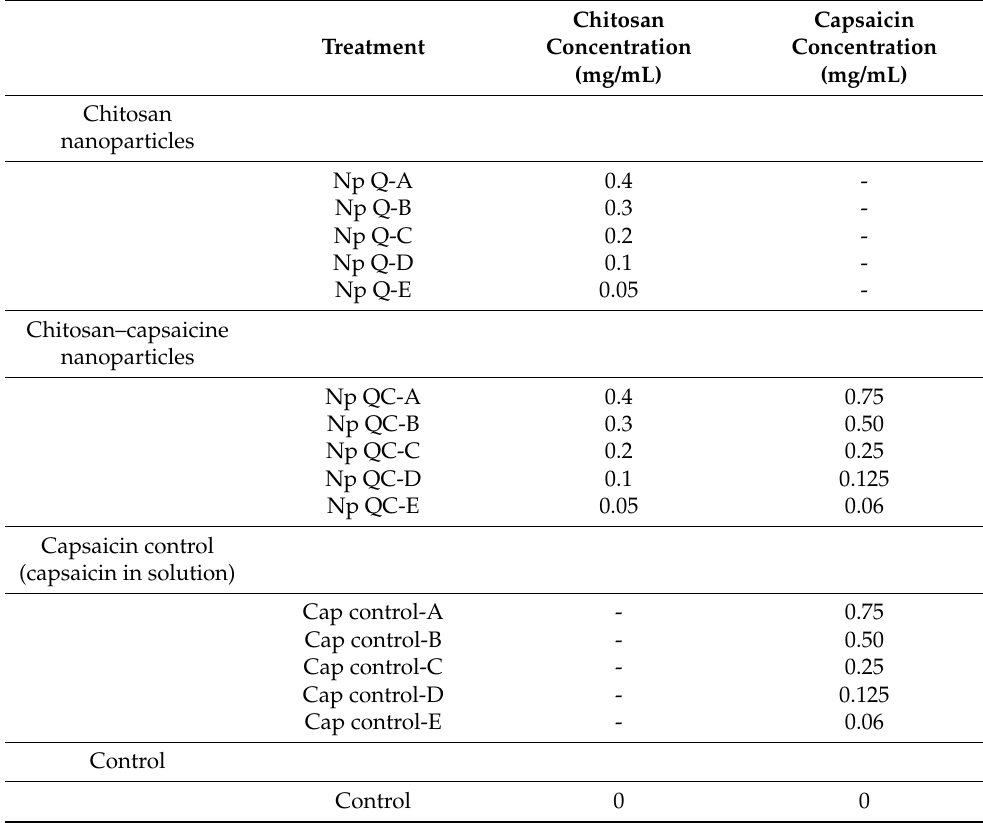
Table 1. Nomenclature used to describe the concentration of both chitosan nanoparticles and chitosan– capsaicin nanoparticles applied in A. parasiticus spores for toxicity and antimicrobial